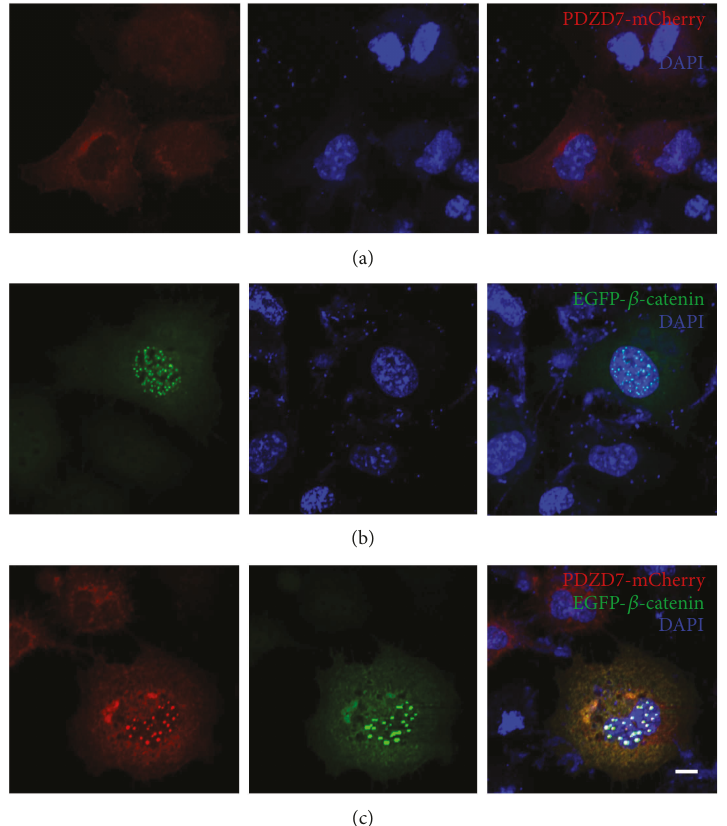
Figure 2: Colocalization of PDZD7 with β -catenin in COS-7 cells. Expression vectors were transfected into COS-7 cells, and the subcellular localization of target proteins was determined using confocal microscopy. (a) PDZD7-mCherry localized in the cytoplasm as well as on the plasma membrane. (b) EGFP- β -catenin mainly localized in the nuclei in a punctate pattern. (c) When expressed together, PDZD7-mCherry colocalized with EGFP- β -catenin in the nuclei. Scale bar: 10 μ m.